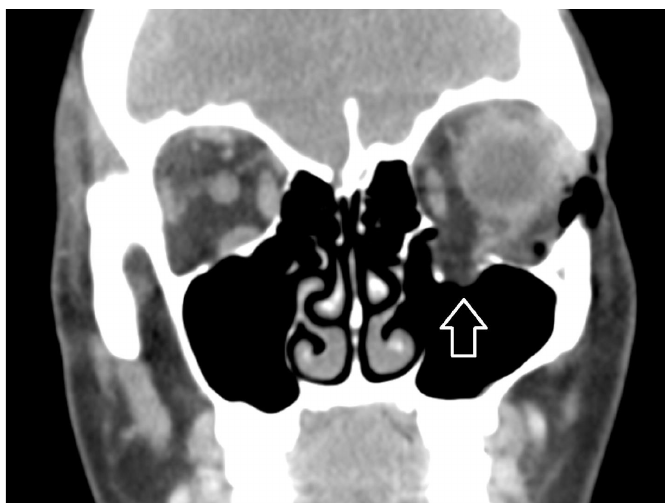
Image 3. Computed tomography shows left orbital floor blowout fracture with herniation of the orbital fat, inferior rectus muscle and inferior oblique muscle into the left maxillary sinus